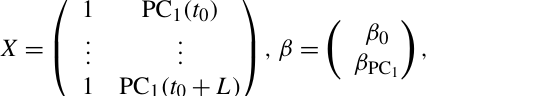
The second method relies on linear regression between